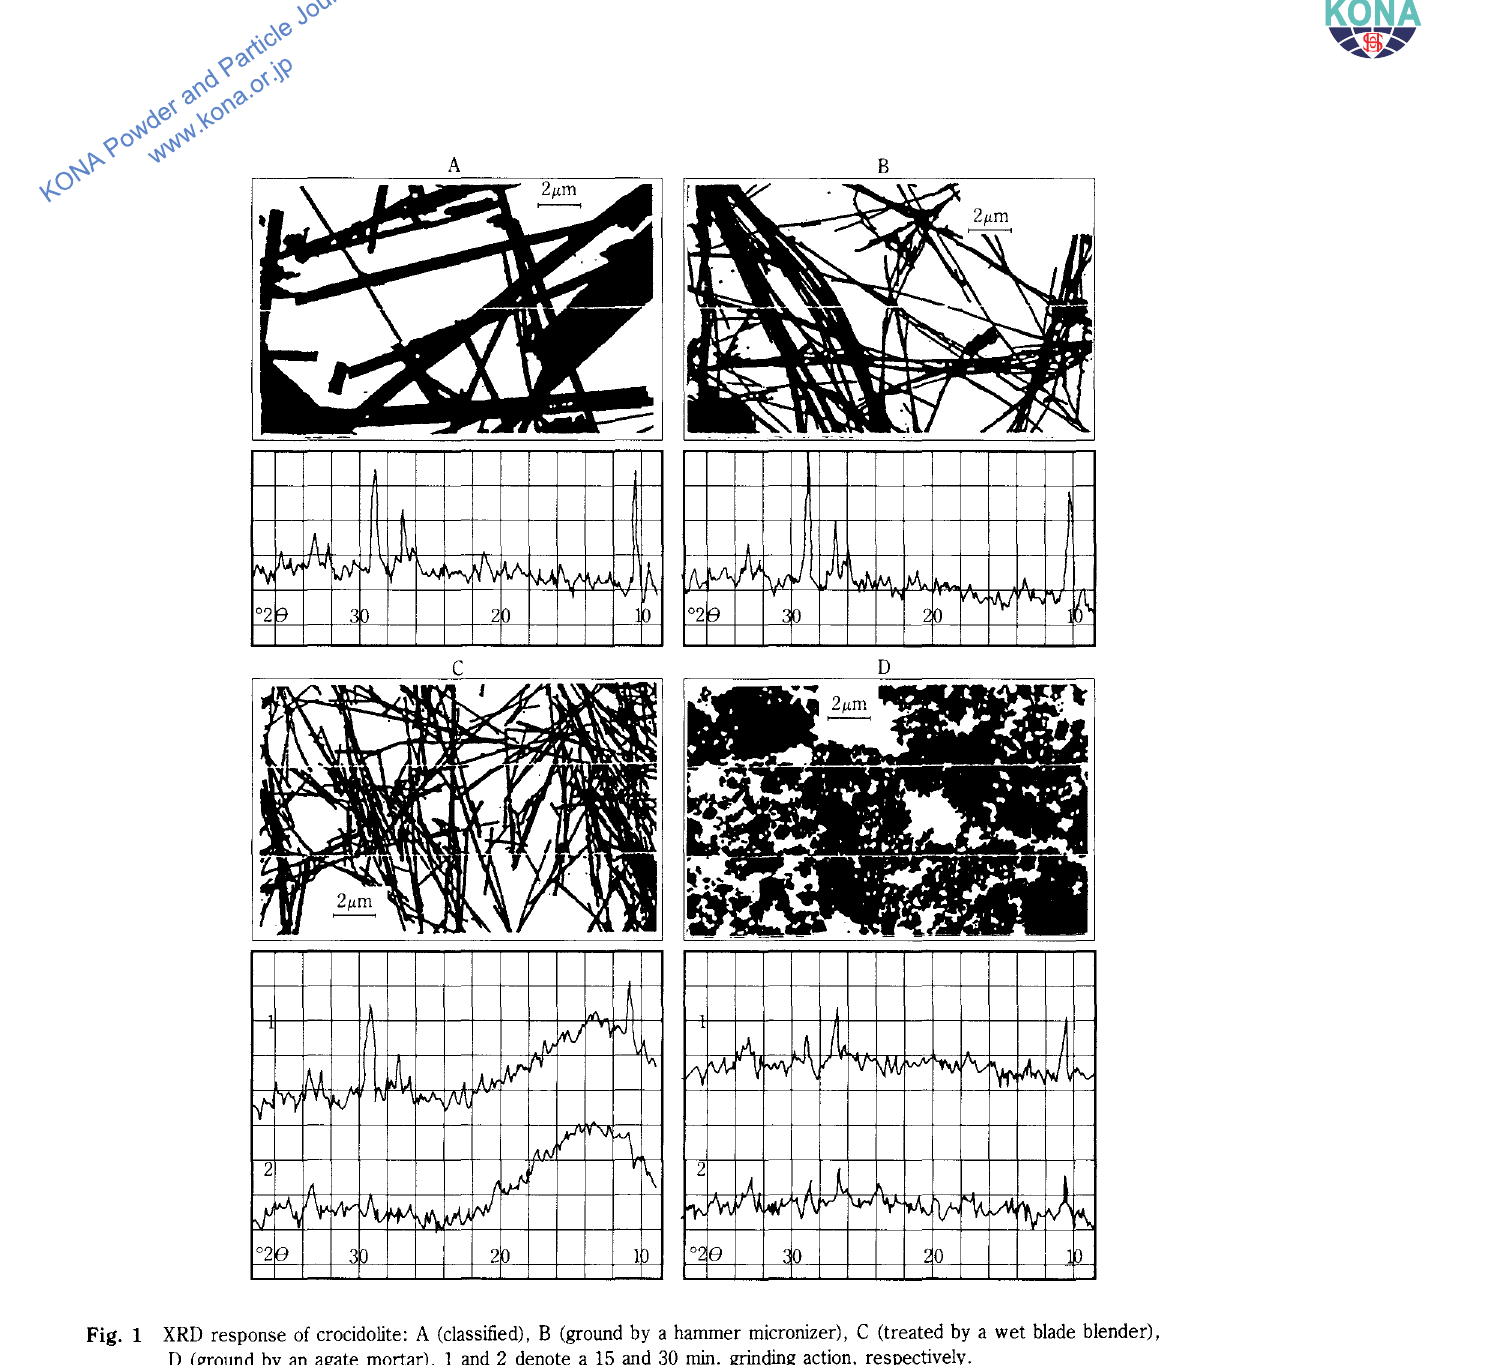
Fig. 1 XRD response of crocidolite: A (classified), B (ground by a hammer micronizer), C (treated by a wet blade blender), D (ground by an agate mortar). 1 and 2 denote a 15 and 30 min. grinding action, respectively. bestos [21]. They first examined the structural modi fications induced by stress and fracture on both Si-0 and Mg-0 interlayer bonding and brucite layer con figuration. The decrease of ''fibre crystallinity'' produces some variations in the physico-chemical properties of finely ground products. Changes in XRD peak areas, IR and ESR spectra and SAED patterns were also analysed: unground and simply classified short fibres or fibres obtained by a "gentle" size reduction or cutting action have a much more relevant crystalline response than products of a "vigorous" ball-mill grinding, where impaction, com pressive and shearing stresses are associated.